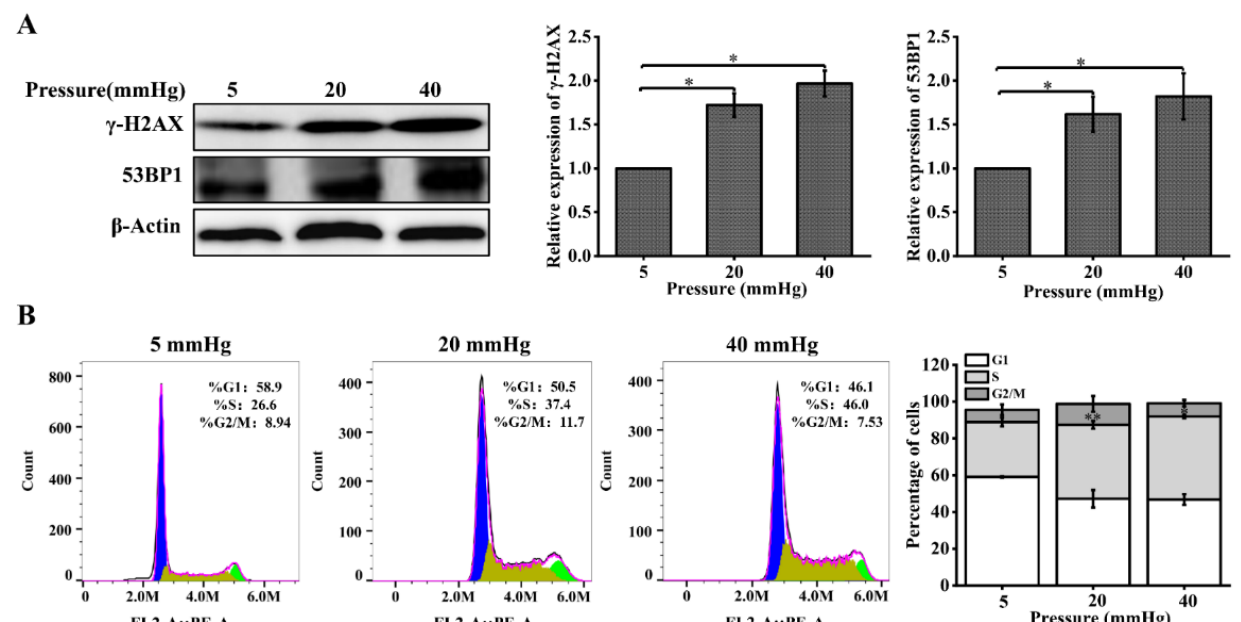
Figure 2. Pressure loading results in increased expression of DNA repair proteins and cell-cycle arrest in hepatocytes: ( A ) DNA repair proteins in hepatocytes were examined with Western blot and quantification data of the expression levels of γ -H2AX and 53BP. The cells were exposed to pressure for 48 h; ( B ) cell-cycle distribution was analyzed using flow cytometry following pressure loading for 48 h. The images are representative of three independent experiments. The stacked bar graph indicates the percentage of cells at various stages of the cell cycle. Data are expressed as the mean ± SD. n = 3, * p < 0.05, ** p < 0.01.